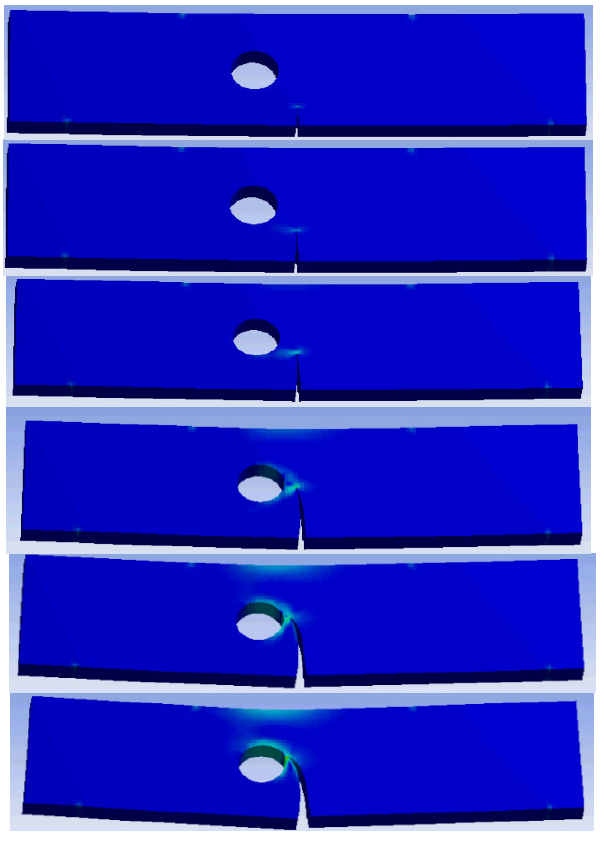
Figure 4. From top to bottom, six different steps of crack growth for the four-point bending beam.